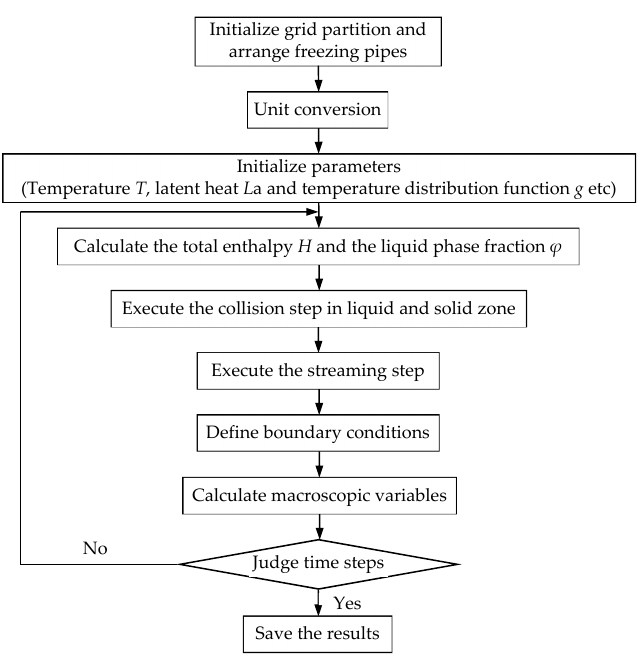
Figure 2 . Flowchart of program realization for soil freezing. Figure 2. Flowchart of program realization for soil